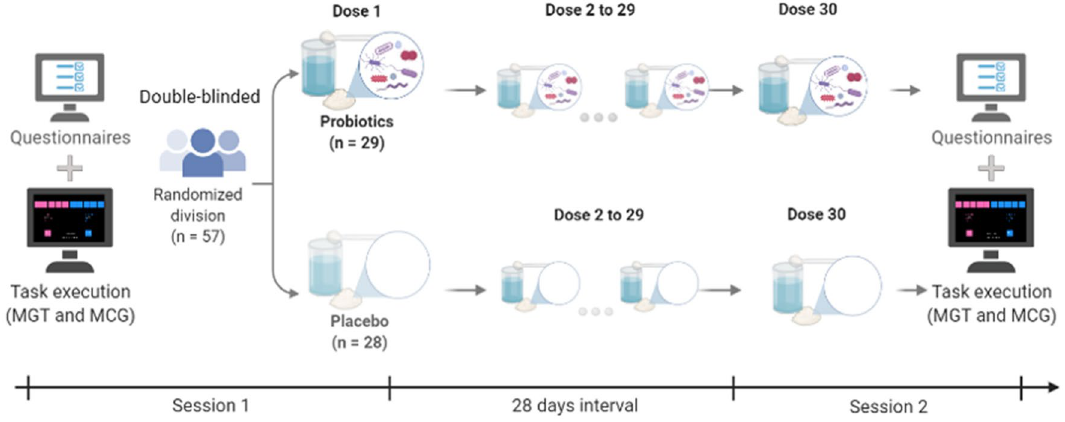
Figure 2. Experimental design. Figure depicts the double-blinded placebo-controlled experimental design, along with the main procedures for both experimental sessions and the probiotics/placebo protocol followed by the participants during the 30 days of the